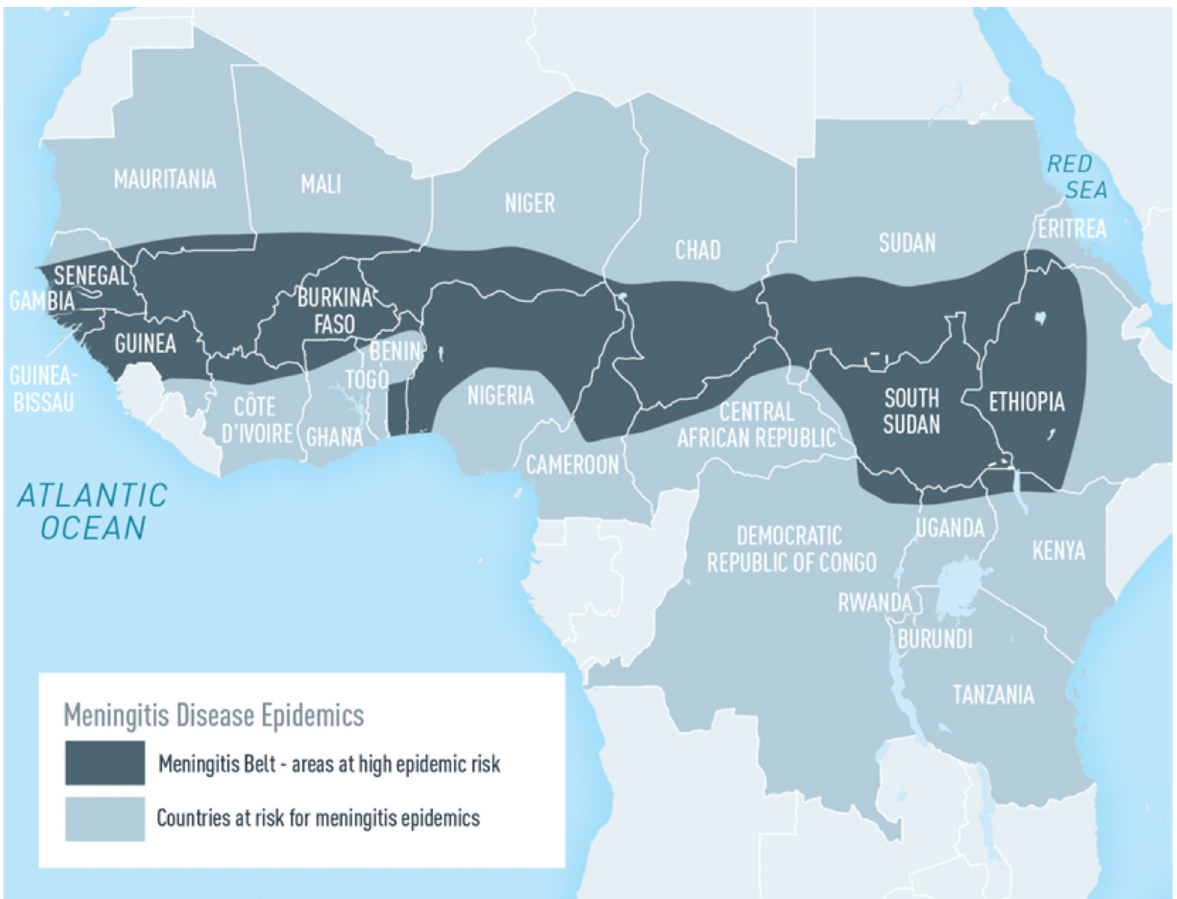
Figure 1. Areas with frequent epidemics of meningococcal meningitis. Disease data source: World Health Organization, International Travel and Health (Geneva, Switzerland, 2015). https://wwwnc.cdc.gov/travel/yellowbook/2020/travel-related-infectious-diseases/meningococcal-disease (accessed 23 March 2022).